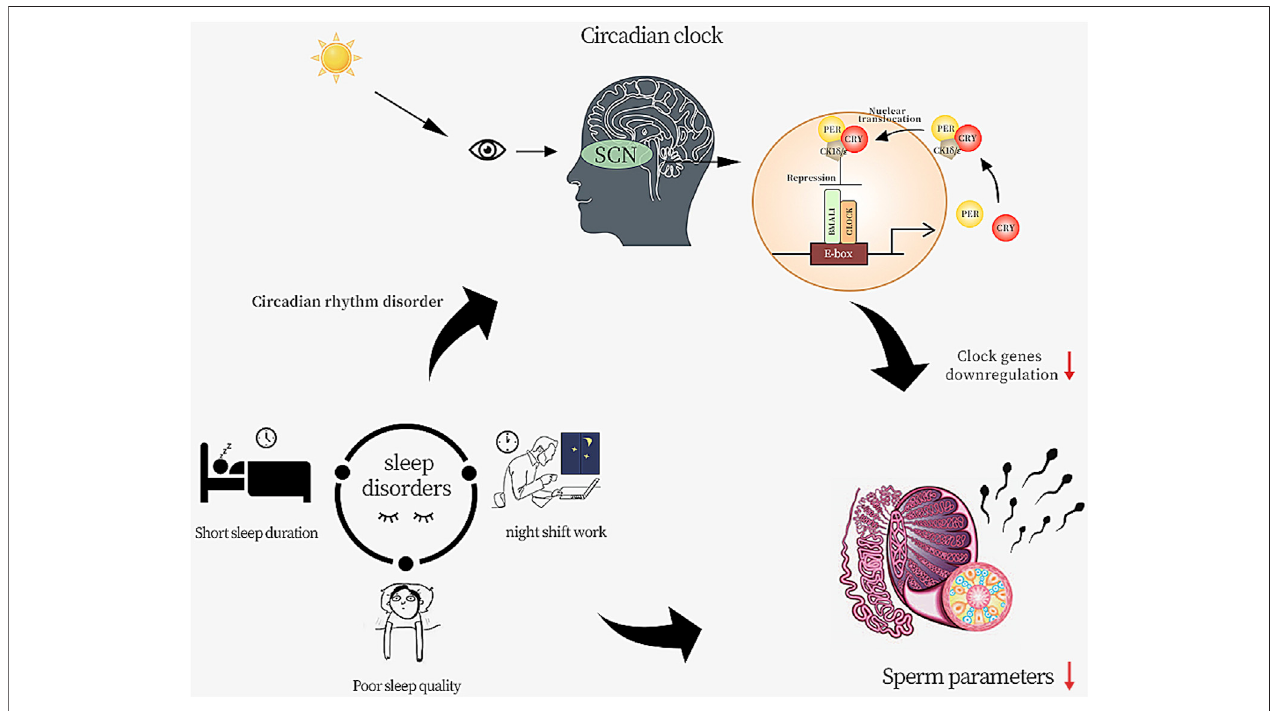
FIGURE 9 | Sleep disorders affect the quality of